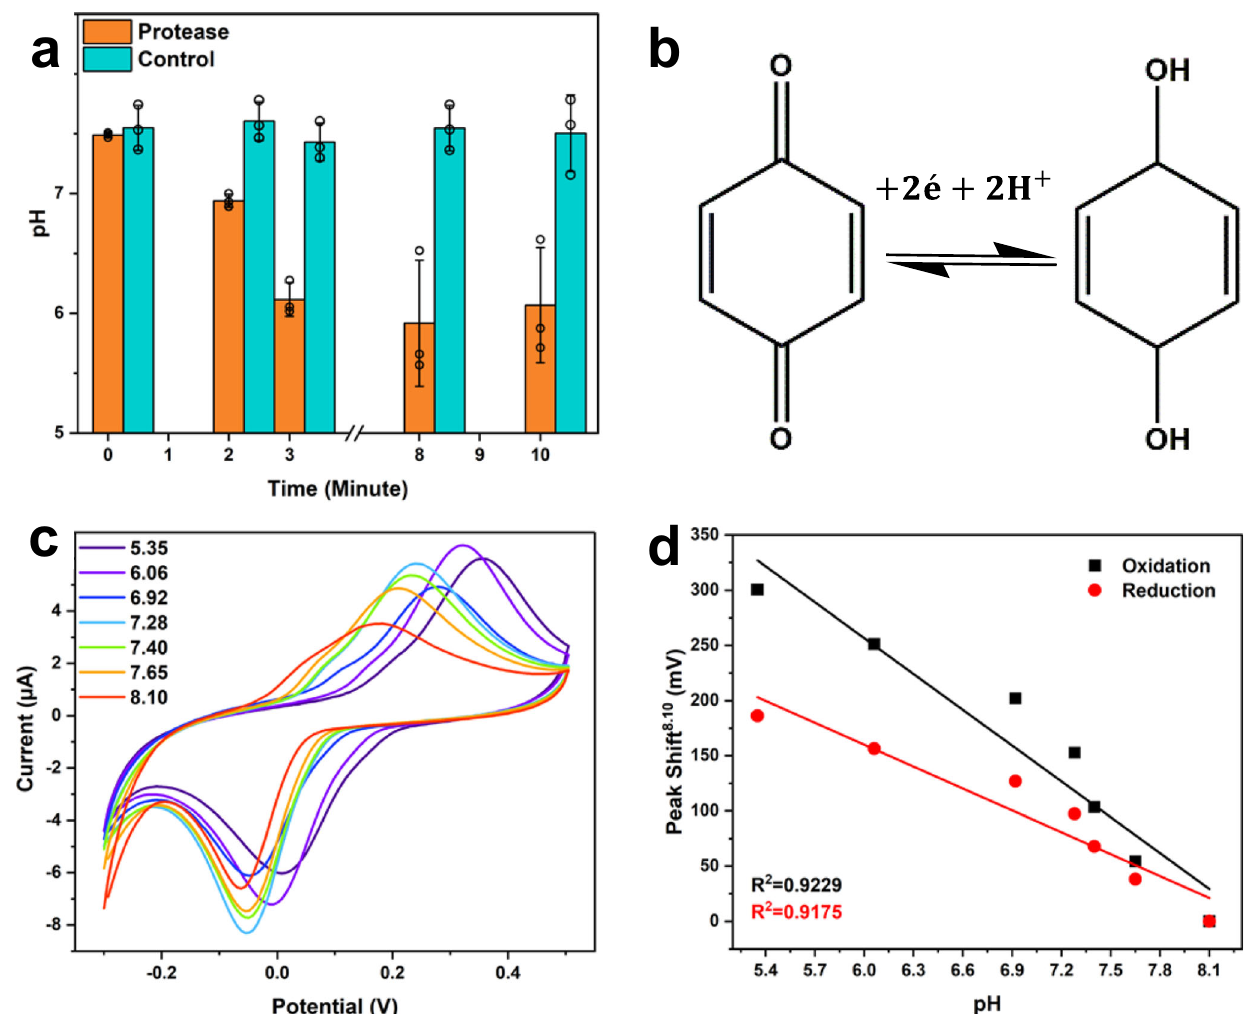
Fig.2|CharacterizationofpBQasaRedOxpHindicator.a MeasuredpHchange caused by 3CL pro (1 μ M ) activity in the presence of 3CL pro substrate (100 μ M , orange plot)andtheabsenceof3CL pro substrate(blueplot),columnsrepresentmean±SD fromthreetechnicalrepetitions. b pBQRedOxreactionmechanisms,dependingon